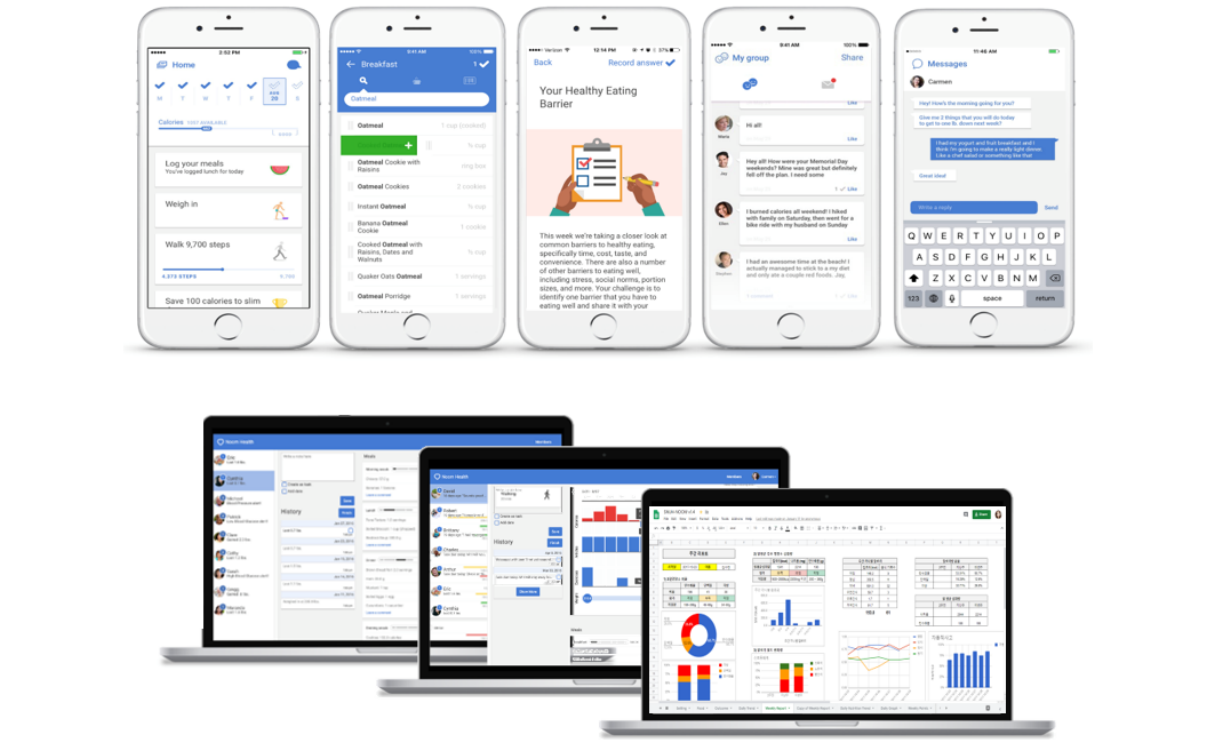
Figure 3. Screenshots of the digital platform (ie, mobile apps) for the participants (top) and screenshots of the digital platform (ie, dashboard) for the therapist (ie, clinical psychologist)